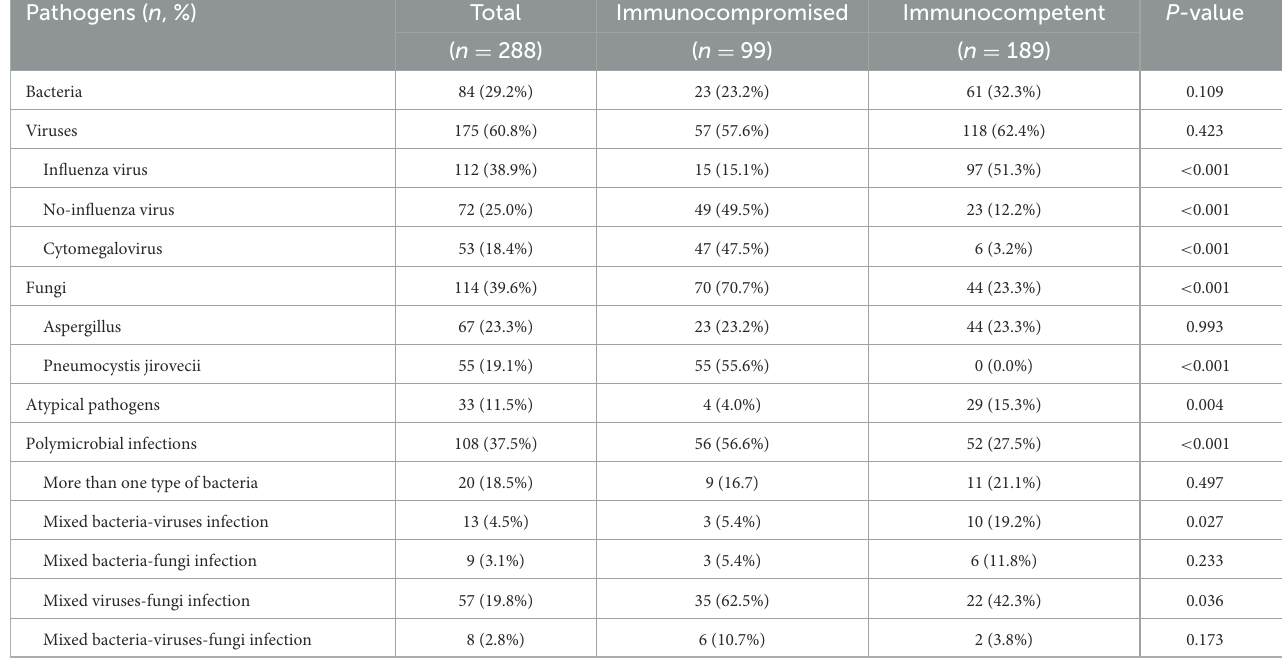
TABLE 2 Characteristics of pathogens in patients with severe community-acquired pneumonia. Pathogens ( n ,